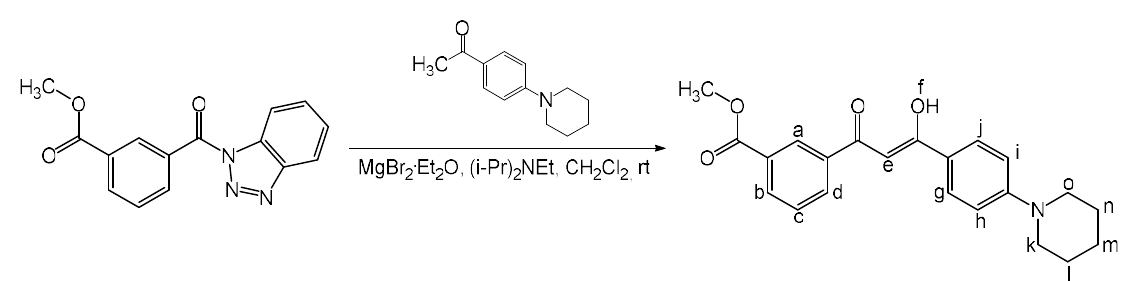
Figure 2. Molecular structure of the title enol. Displacement ellipsoids are shown at 50% probability level.